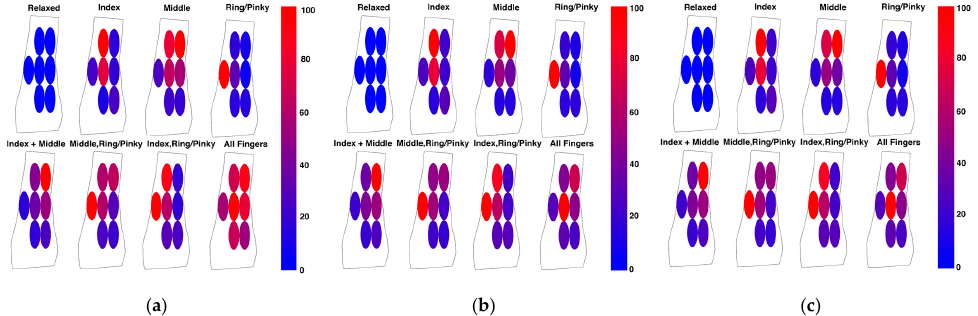
Figure 10. Normalized distribution of feature vectors for different channels during specific hand gestures: ( a ) Willison Amplitude (WAMP); ( b ) Root mean square (RMS), and ( c ) Wavelength (WL).